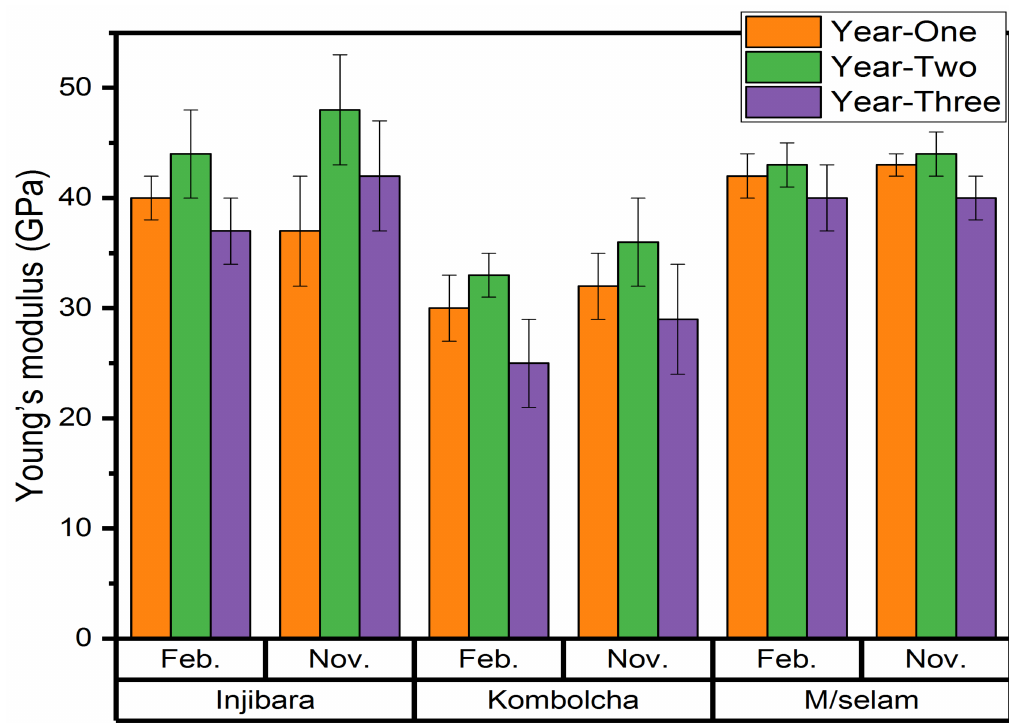
Figure 6. Back-calculated Young’s moduli using